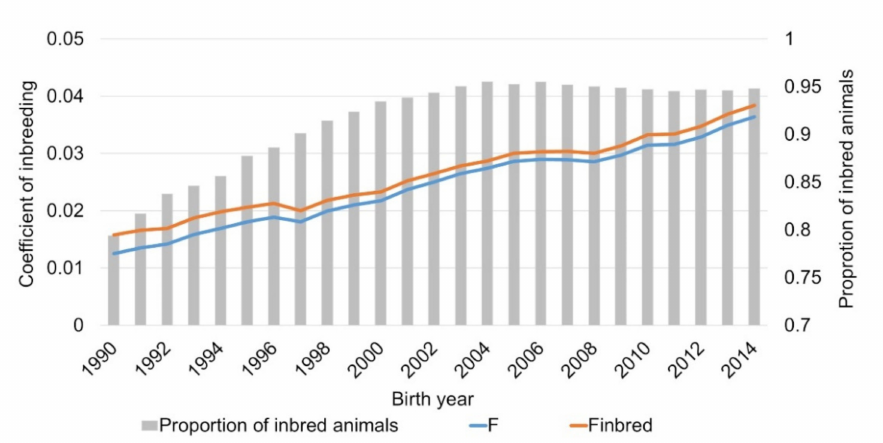
Figure 1. Inbreeding coefficients for all (F) and inbred (F inbred ) German Brown for the birth years 1990 to 2014.